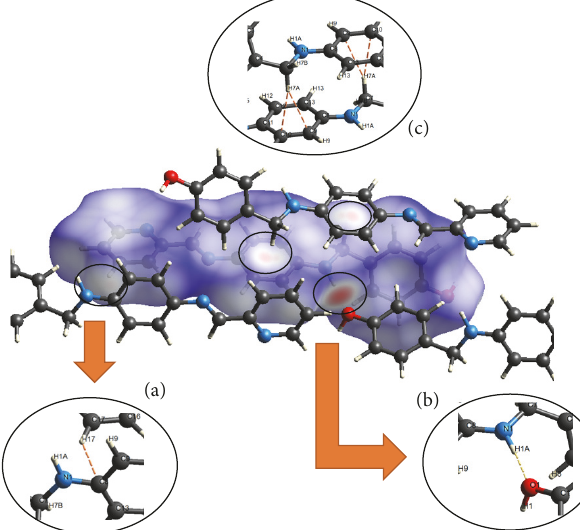
Figure 9: View of EPAF d 𝑛𝑜𝑟𝑚 surface showing the interactions (a) O1-H1...N3 and C14-H14...C1, (b) N1-H1A...O, O1-H1...N3, and C14- H14...C1, and (c) C17-H17...C8.